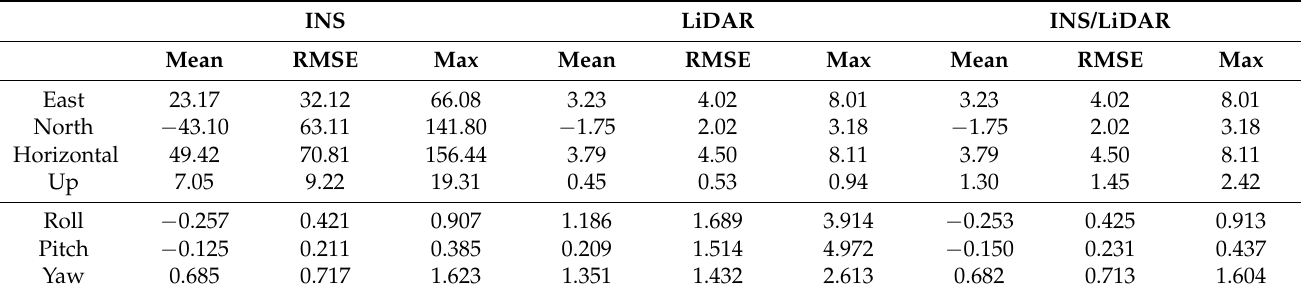
Table A16. D-86—position (m) and attitude (deg) error statistics.